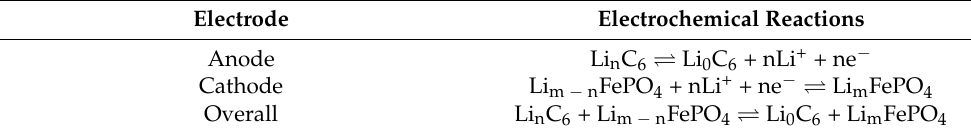
Table 1. Electrochemical reactions of a lithium iron phosphate (LFP) battery.